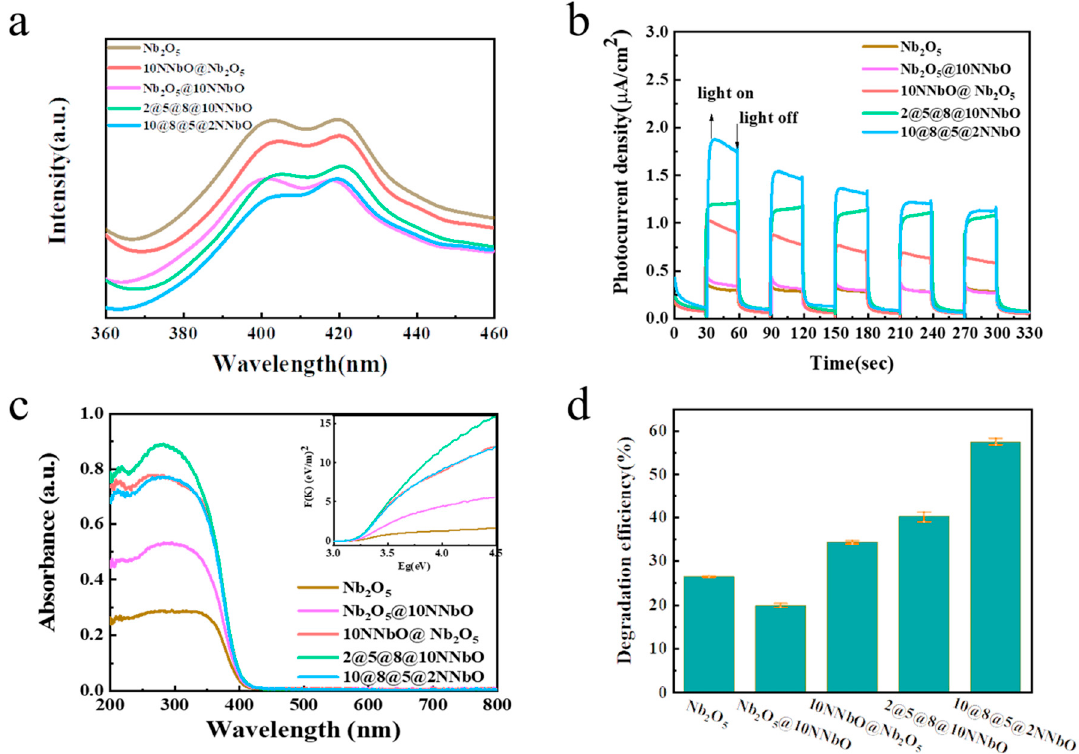
Figure 4. ( a ) Fluorescence spectra and ( b ) photocurrents of nitrogen-doped Nb 2 O 5 under light irra- diation. The illumination from a 300 W xenon lamp was interrupted every 30 s at a bias potential of 0.5 V vs. Ag/AgCl; ( c ) UV-Vis diffuse reflectance spectra and an inserted image of ( α hv) 1/2 vs. hv of the Nb 2 O 5 @10NNbO, 10NNbO@ Nb 2 O 5 , 2@5@8@10NNbO, 10@8@5@2NNbO and Nb 2 O 5 . ( d ) Photo-